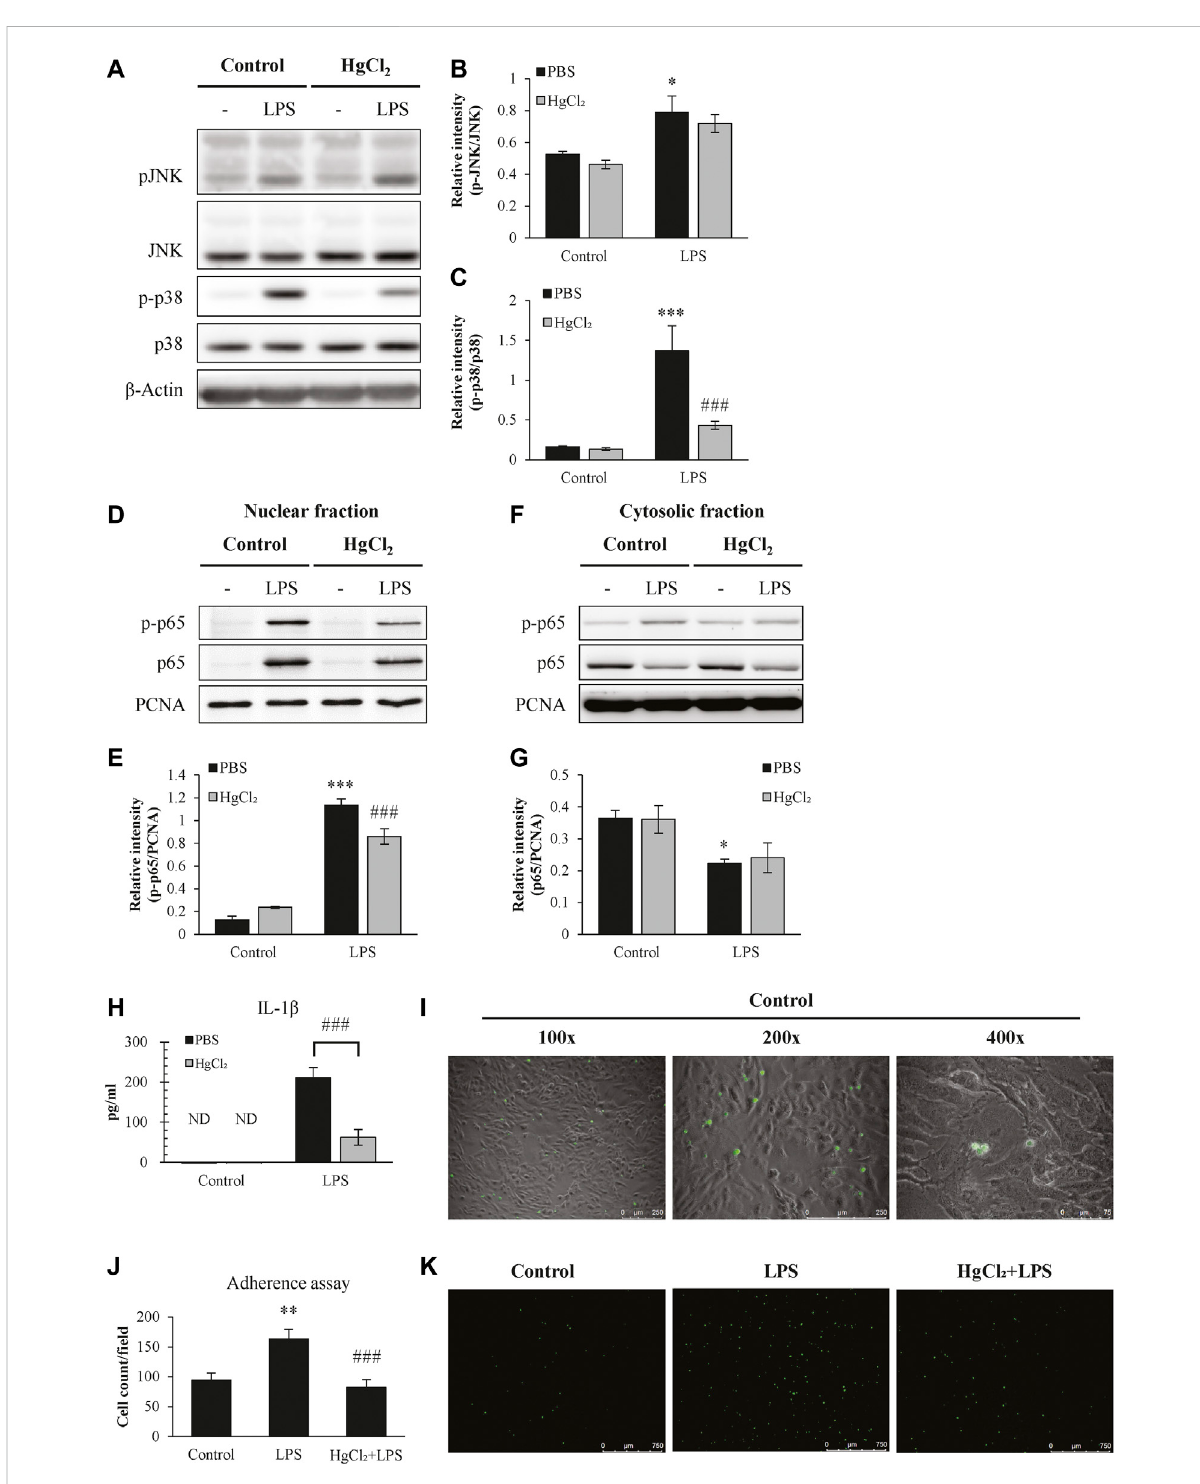
FIGURE 3 HgCl 2 suppress in fl ammatory pathway and adherence function. (A,D,F) In fl ammatory cascade 30 min after lipopolysaccharides (LPS) (1 μ g/ml) andHgCl 2 (1 μ M)treatmentwasdeterminedbywesternblotanalysis.and (B – G) interpretedbysemiquantitativedensitometricanalysis(n=3 – 4). (H) The level of IL-1 β production 24 h after LPS (1 μ g/ml) and HgCl 2 (1 μ M) treatment. (I) Images of adhered BMDMs (green) on LA-4 murine lung epithelium(DIC)indifferentmagni fi cation(×100,200×,and400×). (J,K) AdheredBMDMs(green)inadherenceassaywereimagedandcounted by fl uorescence microscope (50×) and imageJ (n = 7 – 11). Values are mean ± SEM. ** p = 0.001 vs. control. *** p < 0.001 vs. control. ### p < 0.001 vs.